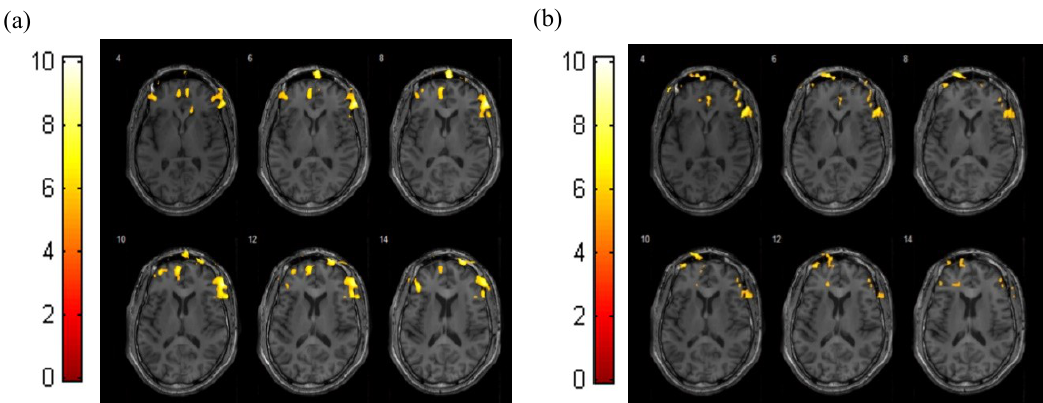
Figure 4. T-maps of brain activation measured by DOT and functional magnetic resonance imaging (fMRI) devices in the same subject. All results were mapped onto individual anatomy. Threshold p < 0.001 corrected false discovery rate (FDR), at the voxel level for BOLD signal (a) and HbO signal (b) in a healthy subject. Note that cerebral activation maps provided by DOT data filtered with a Bayesian method follow a similar spatial distribution to maps provided by fMRI, using the general Linear Model (GLM) as a statistical method for both neuroimaging modalities. Representation of number of voxels common by anatomical area between oxyhemoglobin-blood-oxygen level-dependent (HbO-BOLD) (T: 2.33, p < 0.05).